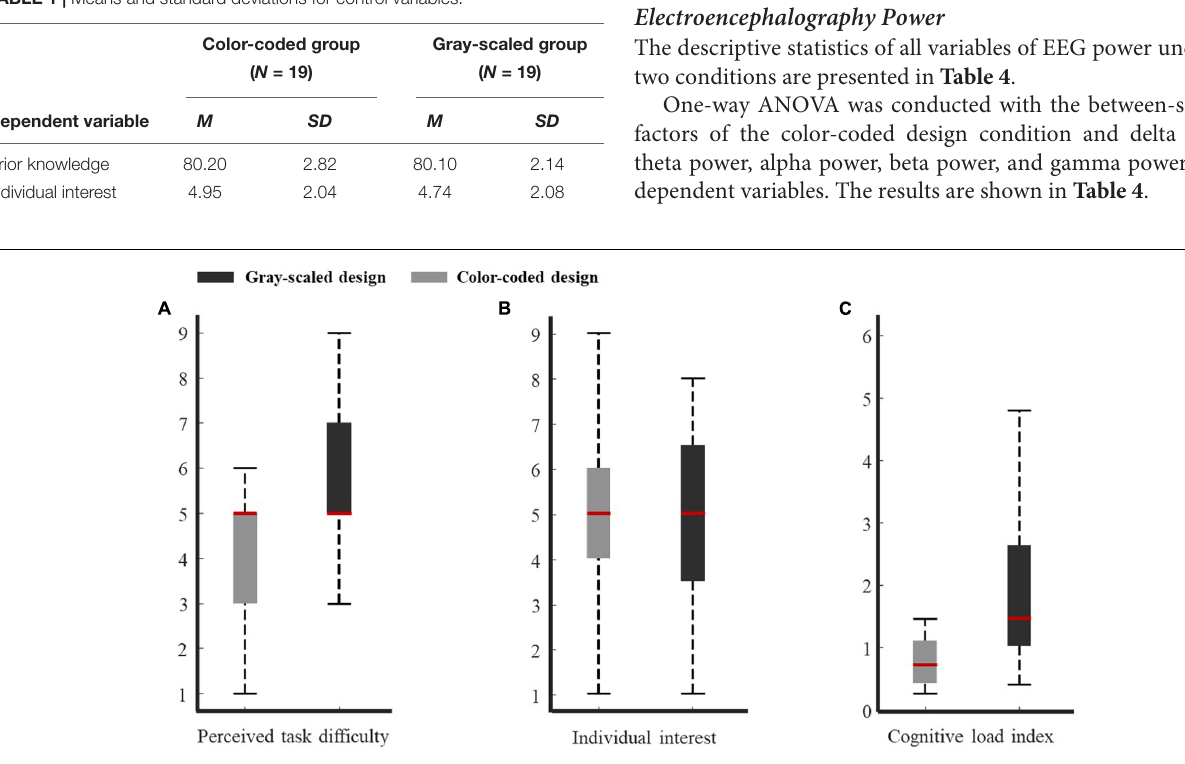
Frontiers in Psychology |